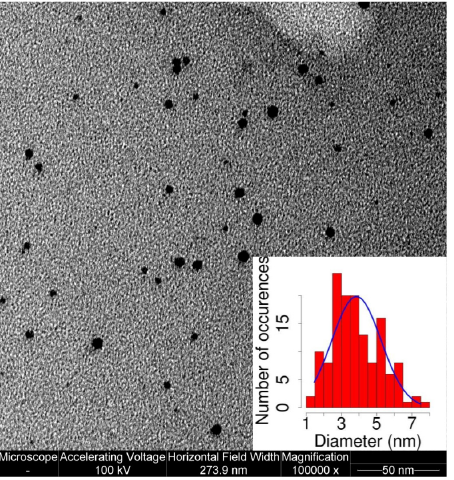
Figure 3. TEM micrograph of 2.5 μ M MPA ‐ AuNPs and 25 μ M β 2m. The average NP diameter measured in presence of the protein was 3.8 ± 1.3 nm.